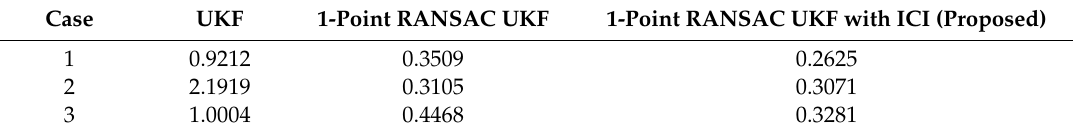
Figure 7. The last experimental results of height estimation with bias type measurement error in the last period (7775 to 7776 time-step): case 3. Table 3. RMSE of experiments.